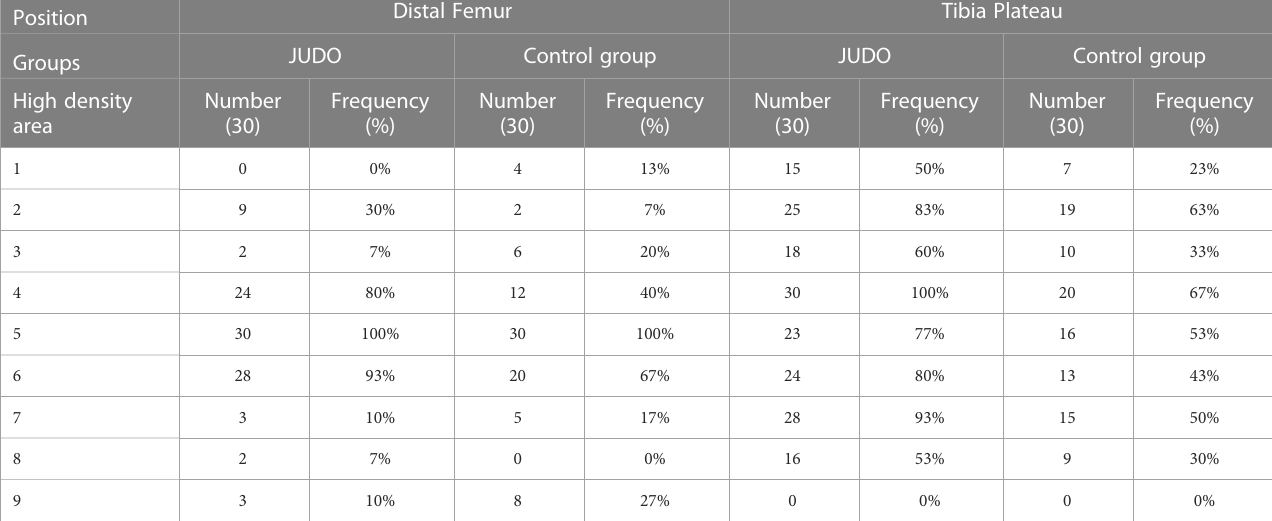
TABLE 2 knee articular bone density distribution pattern classi fi cation data. Position Distal Femur Tibia Plateau Groups